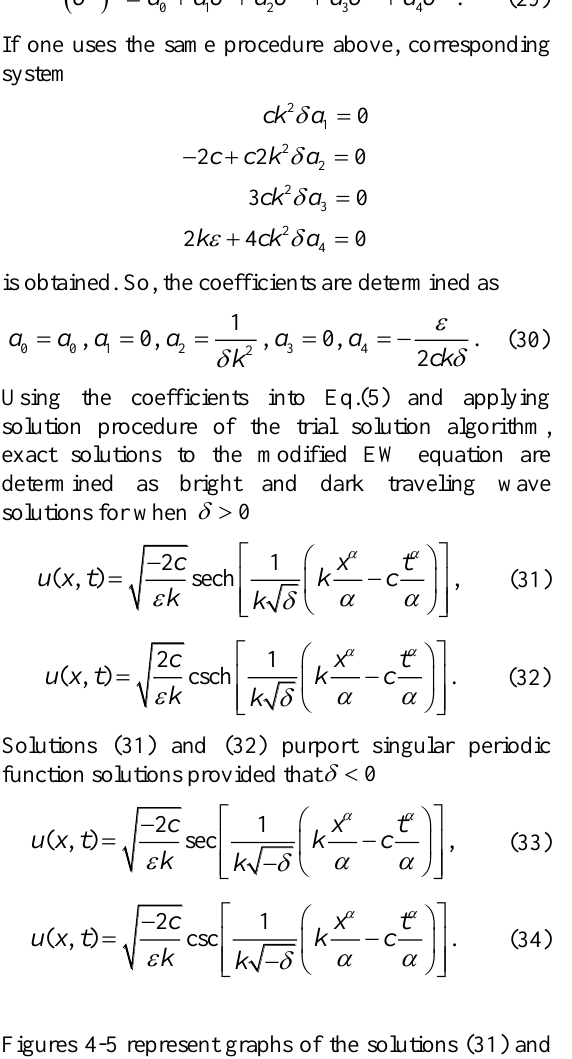
(c) Solution Eq.(31) for 1 = Figure 4. Solution Eq.(31) for 1, 2 c k  = = = = − and indicated 